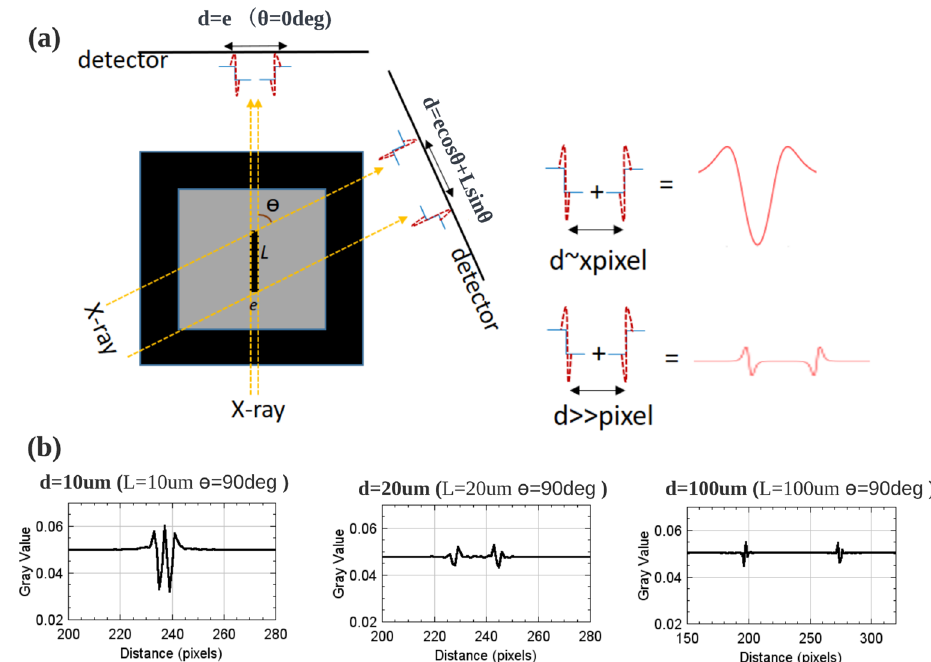
Figure 11. Qualitative explanation of the effect of crack length on the gray-scale values of the cracks in the reconstructed images. ( a ) Schematic diagram of a crack acquisition during scan. In phase contrast tomography, the edges of the crack (marked in blue) generate sharp signals on the detector (marked in red), and an interaction when they are close, causing a high intensity on the detector (at the center of the crack); ( b ) Simulated intensity signals generated at the detector for a given angle ( θ = 90 ◦ ) and different lengths of cracks (L = 10 µ m/20 µ m/100 µ m, e = 3 µ